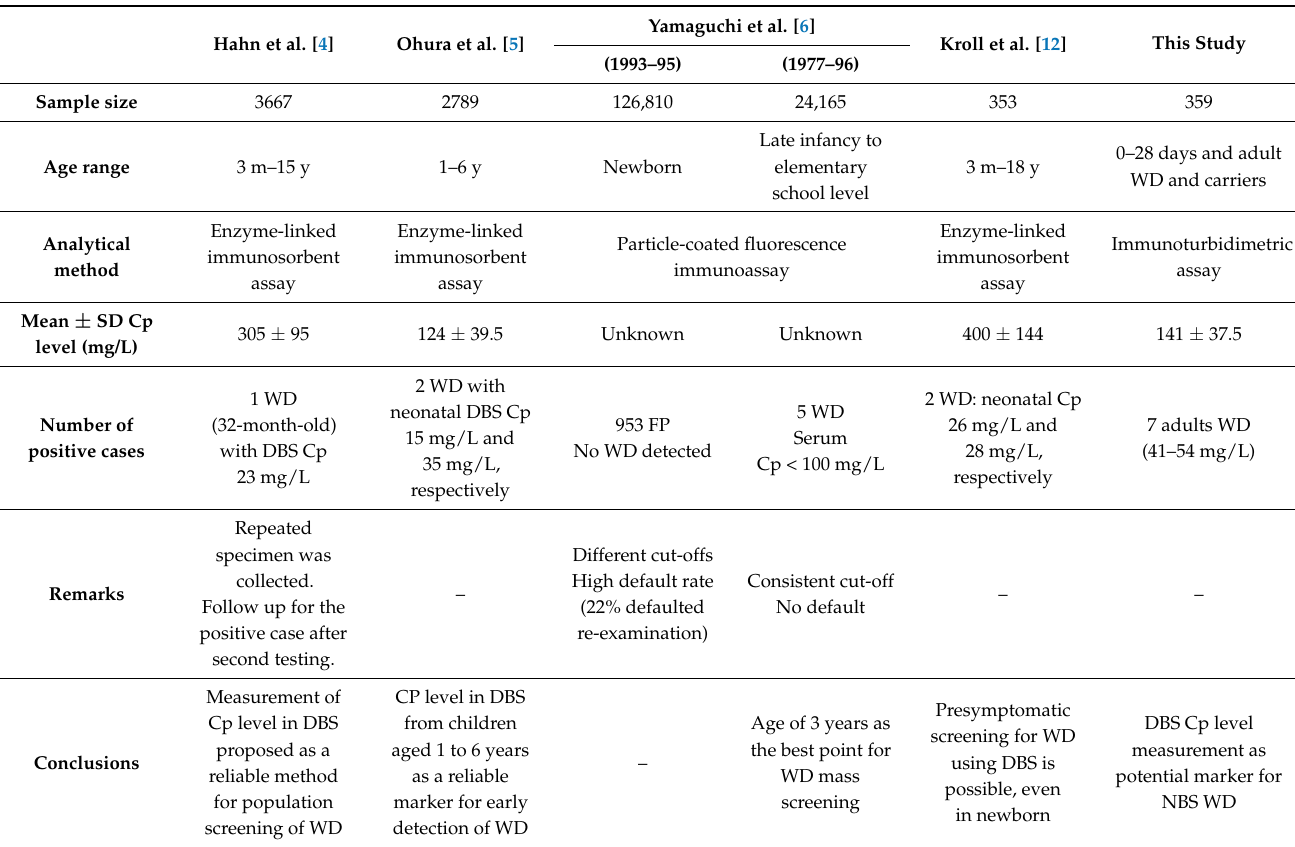
Table 1. Comparison of WD screening studies (Cp: ceruloplasmin; FP: false